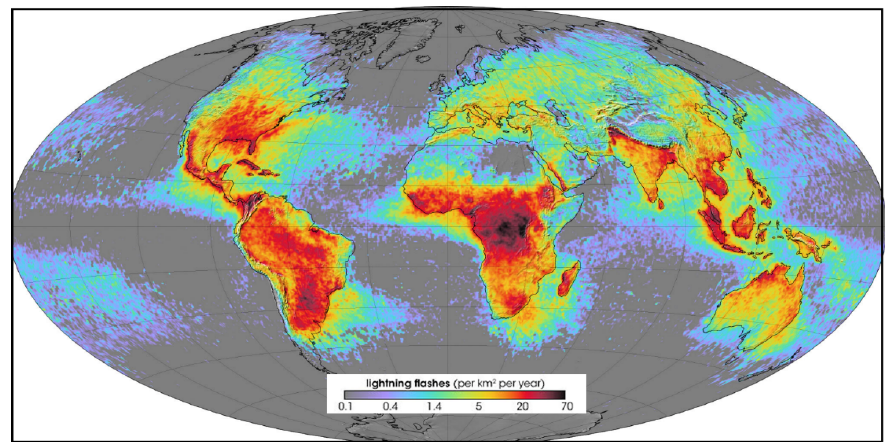
Medicina 2021 , 57 , x FOR PEER REVIEW Figure 5. Map of world lightning frequency from NASA. Figure 5. Map of world lightning frequency from NASA.